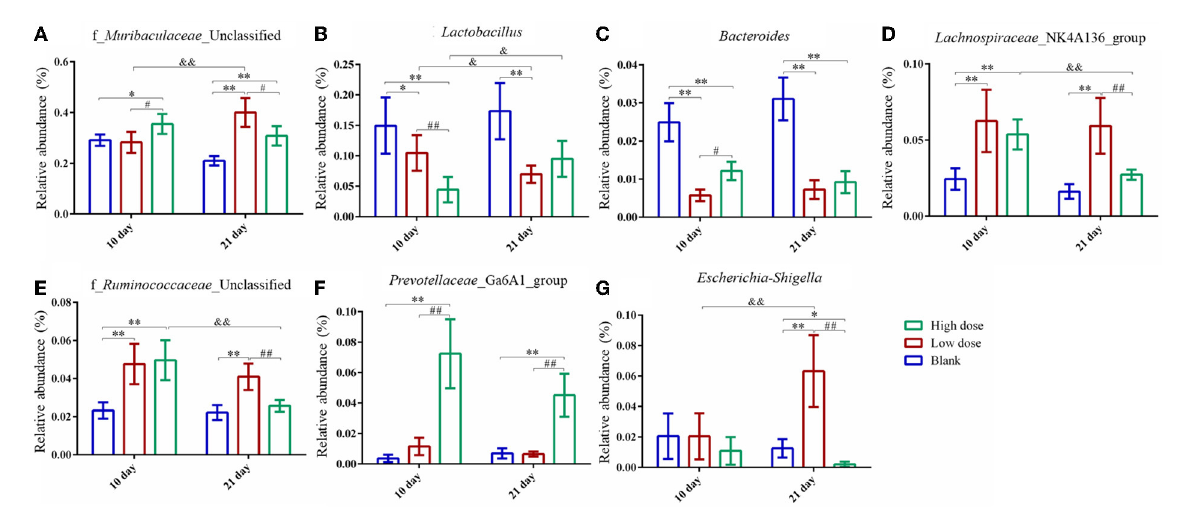
FIGURE7 Species with significantly relatively high abundance and significant differences at genus level. (A) f_ Muribaculaceae _Unclassified; (B) Lactobacillus ; (C) Bacteroides ; (D) Lachnospiraceae _NK4A136_group; (E) f_ Ruminococcaceae _Unclassified; (F) Prevotellaceae _Ga6A1_group;